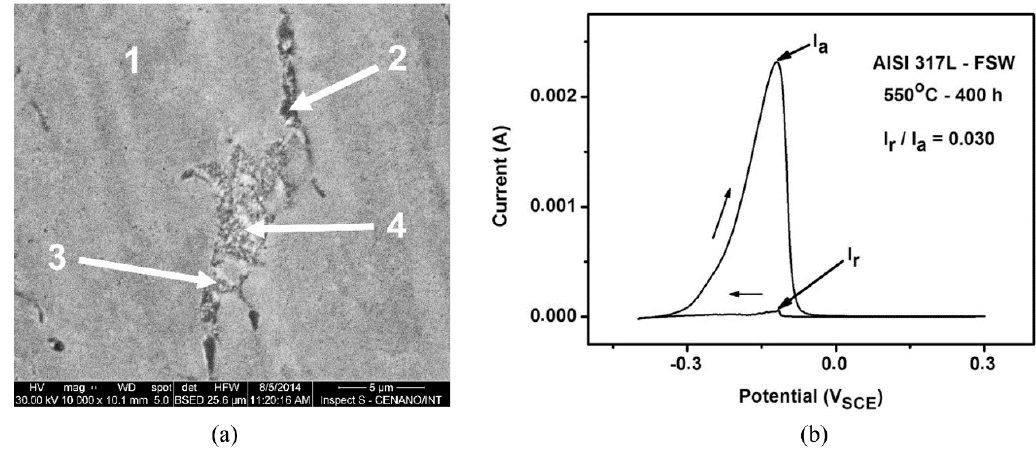
Figure 5. (a) Microstructure and (b) DL-EPR curve of specimen aged at 550 °C for 400 h.